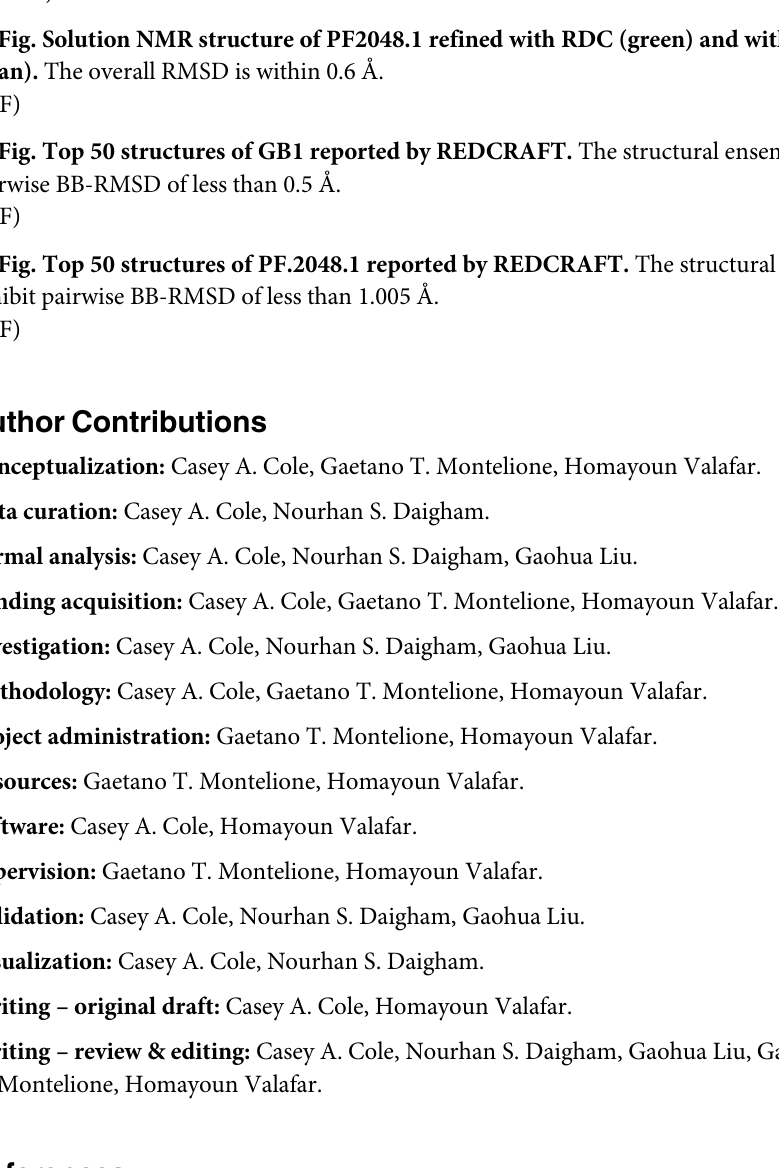
S1 Table. Structure Calculation Input Files for PF2048.1. S2 Table. Structure Quality Statistics for PF2048.1. S1 Fig. Solution NMR structure of PF2048.1 refined with RDC (green) and without RDC (cyan). The overall RMSD is within 0.6 Å . S2 Fig. Top 50 structures of GB1 reported by REDCRAFT. The structural ensemble exhibit pairwise BB-RMSD of less than 0.5 Å . S3 Fig. Top 50 structures of PF.2048.1 reported by REDCRAFT. The structural ensemble exhibit pairwise BB-RMSD of less than 1.005 Å